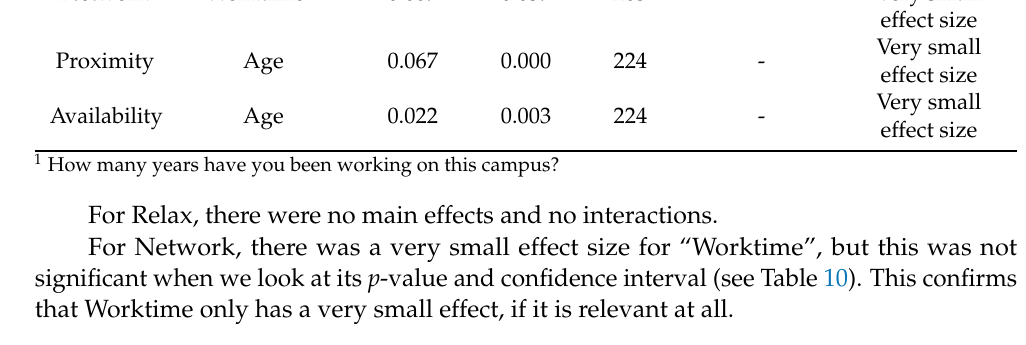
Table 10. Final regression model for